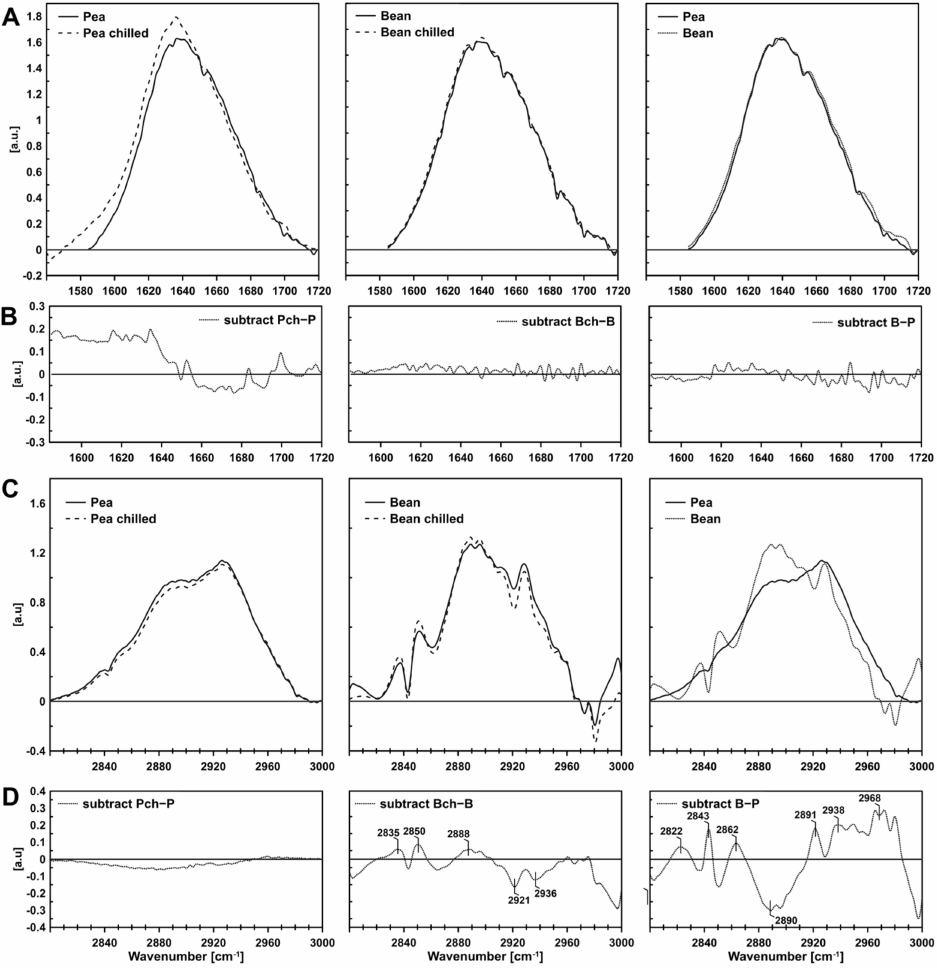
Figure 3. Representative spectra of infrared spectroscopy: the Amide I region ( A ) and its subtracts ( B ), the lipid acyl chains region ( C ) and its subtracts ( D